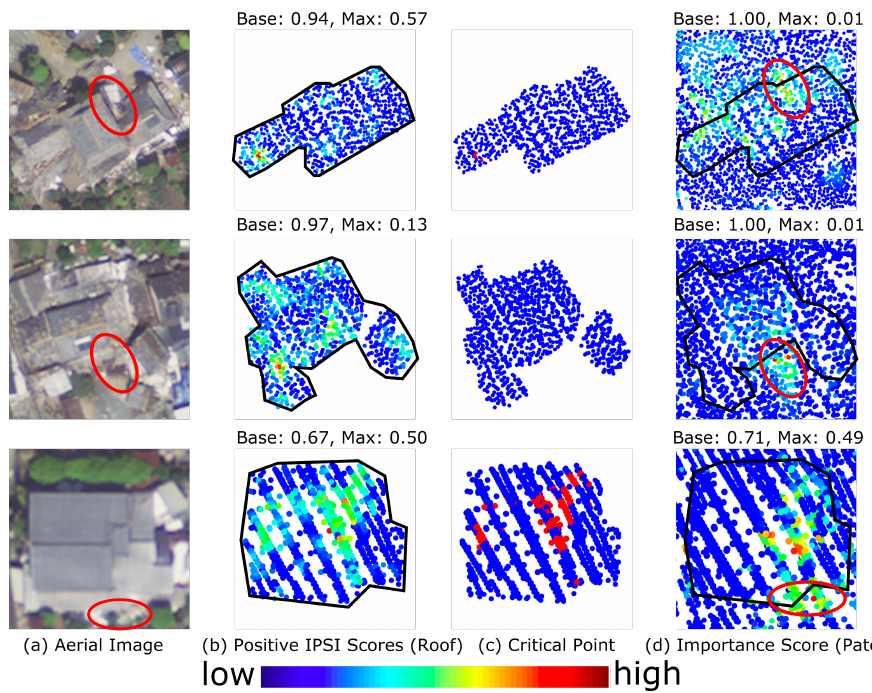
Figure 9. Results of sensitivity analysis: The low-to-high scale bar shows the positive Iterative Partial Set Importance (IPSI) score within each building instance. The baseline probability and maximum importance values are shown in ( a ) and ( d ). ( a ) shows the aerial images [12]; ( b ) shows the positive IPSI scores (roof); ( c ) shows “critical points” that change the classification results if they are removed; and ( d ) shows the positive IPSI scores